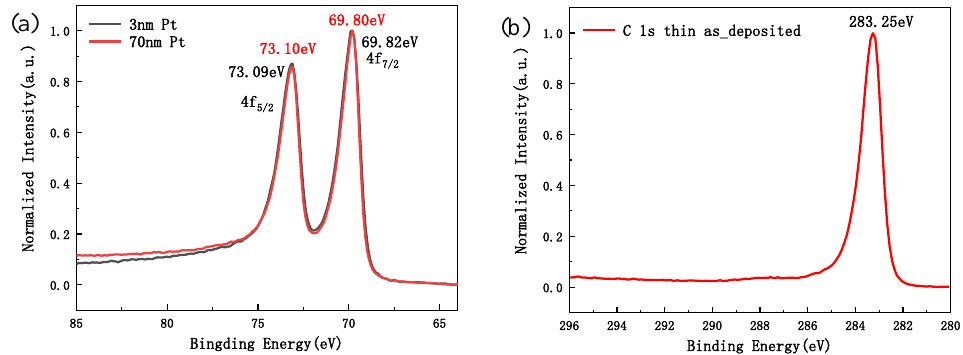
Figure 6. ( a ) XPS spectrums of Pt peaks (red line for 3 nm Pt, black line for 70 nm Pt), ( b ) XPS